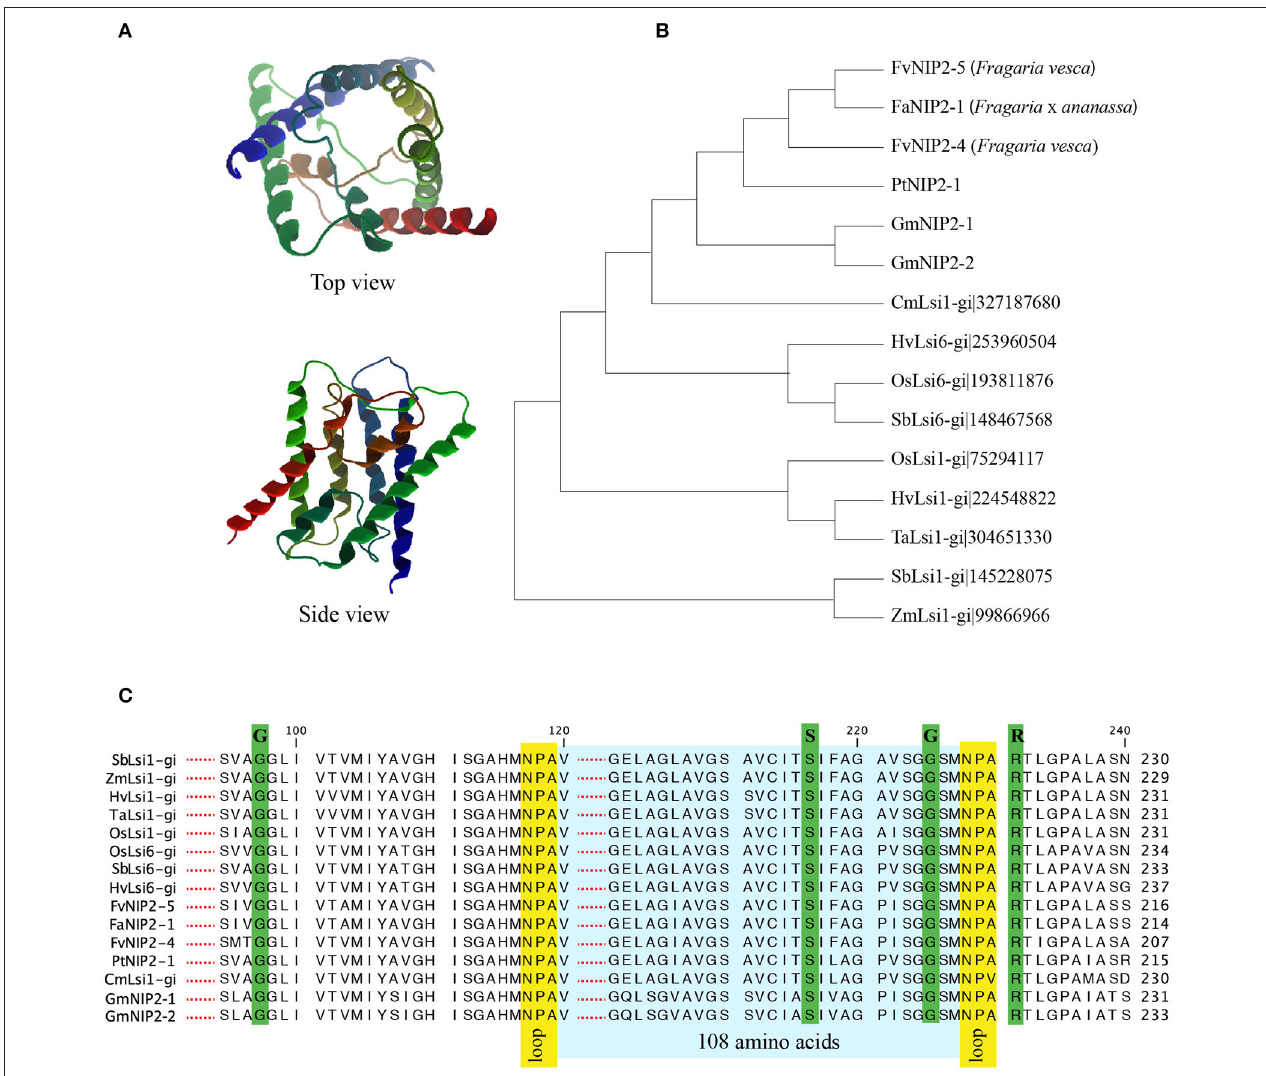
FIGURE 1 | (A) Three-dimensional structure of putative silicon transporters in strawberry; (B) Cladogram of NIP2 from Fragaria spp. with confirmed silicon transporters from other plant species; (C) Alignment of NIP2s, from Fragaria spp., with sequences of confirmed Lsi1. The entire protein sequences are provided in Supplementary Data sheet 1. Fa, Fragaria × ananassa , Fv, Fragaria vesca , Pt, Populus tremuloides , Gm, Glycine max , Cm, Cucumis melo , Hv, Hordeum vulgare , Os, Oryza sativa , Sb, Sorghum bicolor , Ta, Triticum aestivum , Zm, Zea mays